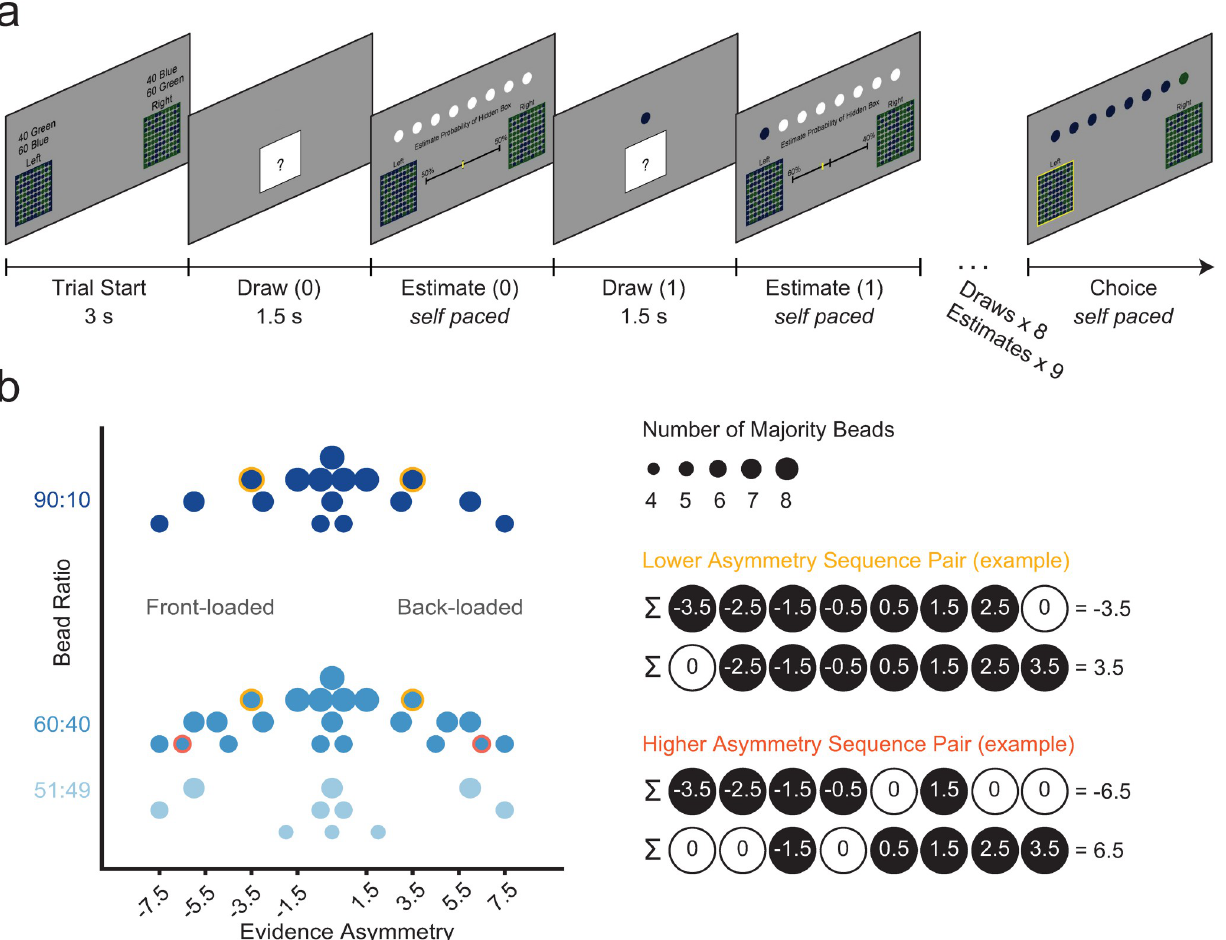
Fig 1. Task schematic. (a) Trial structure of the probability-estimates beads task. Participants are first shown two boxes, a ‘green box’ mostly filled with green beads and a ‘blue box’ mostly filled with blue beads. The ratio of blue to green beads (bead ratio) is shown. Participants are instructed that one of these two boxes, referred to as the “hidden box”, is selected at random, and that their task is to estimate which box is the hidden box based on beads drawn from it. Next, they are shown an obscured representation of the hidden box, but no bead is drawn. Participants then make a first probability estimate using a slider to indicate their perceived probability that the hidden box is either the blue or green box. White circles on top of the screen are used as placeholders to illustrate the remaining samples that will be drawn during the trial. After this first estimate, participants see the hidden box again but this time a bead rises out of the box. Participants are then asked to report a second probability estimate after seeing the first bead. The drawn bead replaces the leftmost available placeholder, starting a sequential visual record of beads drawn during a trial. This process of drawing and estimating repeats until participants have observed 8 samples and reported 9 estimates per trial. At the end of the trial, participants make a binary choice of the box they believe is the hidden box. After this choice, a new trial begins. (b) Task variable space showing bead-ratio conditions on the y-axis (each shown in a different shade of blue) and an evidence-order metric (evidence asymmetry) on the x-axis, with negative values indicating front-loading of majority beads (more majority beads, beads consistent with the identity of the hidden box, in the first half of the 8-bead sequence) and positive values indicating back-loading (more majority beads in the second half). The absolute value of the x axis corresponds to more extreme front- or back-loading (the most extreme being a sequence where 5 majority beads are all in the front or all in the back, respectively, and the least extreme being sequences where beads are evenly distributed around the middle). Larger circles reflect sequences with more majority beads. Sequences are organized in mirror-opposite pairs, with two example pairs shown on the right. Note that the examples illustrate majority beads as black and minority beads as white (albeit in the task majority beads were green or blue consistent with the identity of the hidden box in a given trial). Trials were selected to span the full range of the evidence asymmetry space while avoiding confounds with the bead-ratio condition (Fig 1B) and cumulative evidence (S1 Fig). seeing 8 bead samples and reporting 9 estimates, participants made a binary choice about the hidden box. Critically, the task included various novel manipulations at the trial level to allow 2): we systematically manipulated evidence strength (majority-to-minority ratio of bead colors